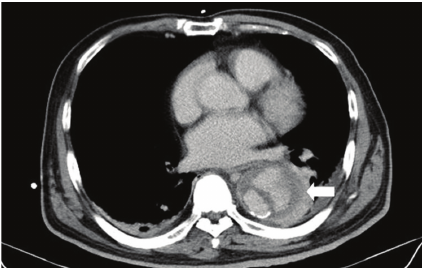
Figure 2: Computed tomography of chest showed progressive dilated aorta and enlarged intramural hematoma